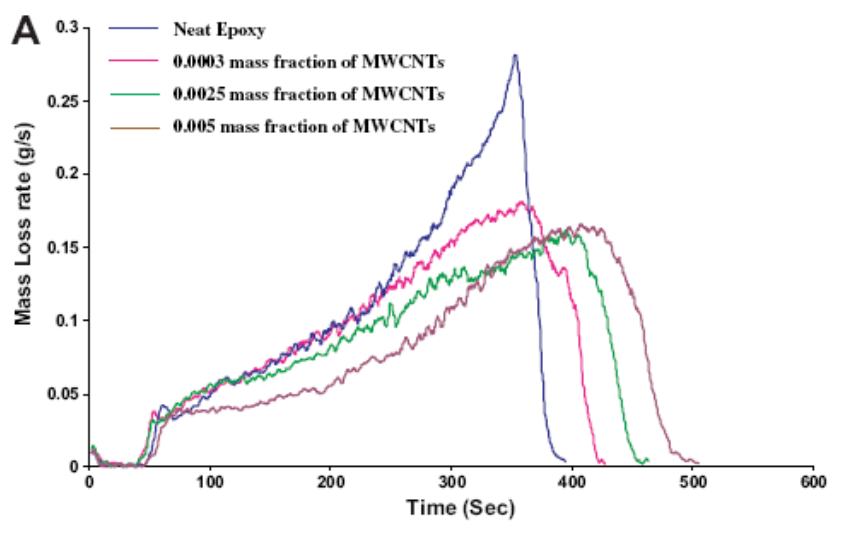
Figure 6. Mass loss rate versus time for different CNT-containing epoxies (heat flux: 50 kW/m², N atmosphere) 2